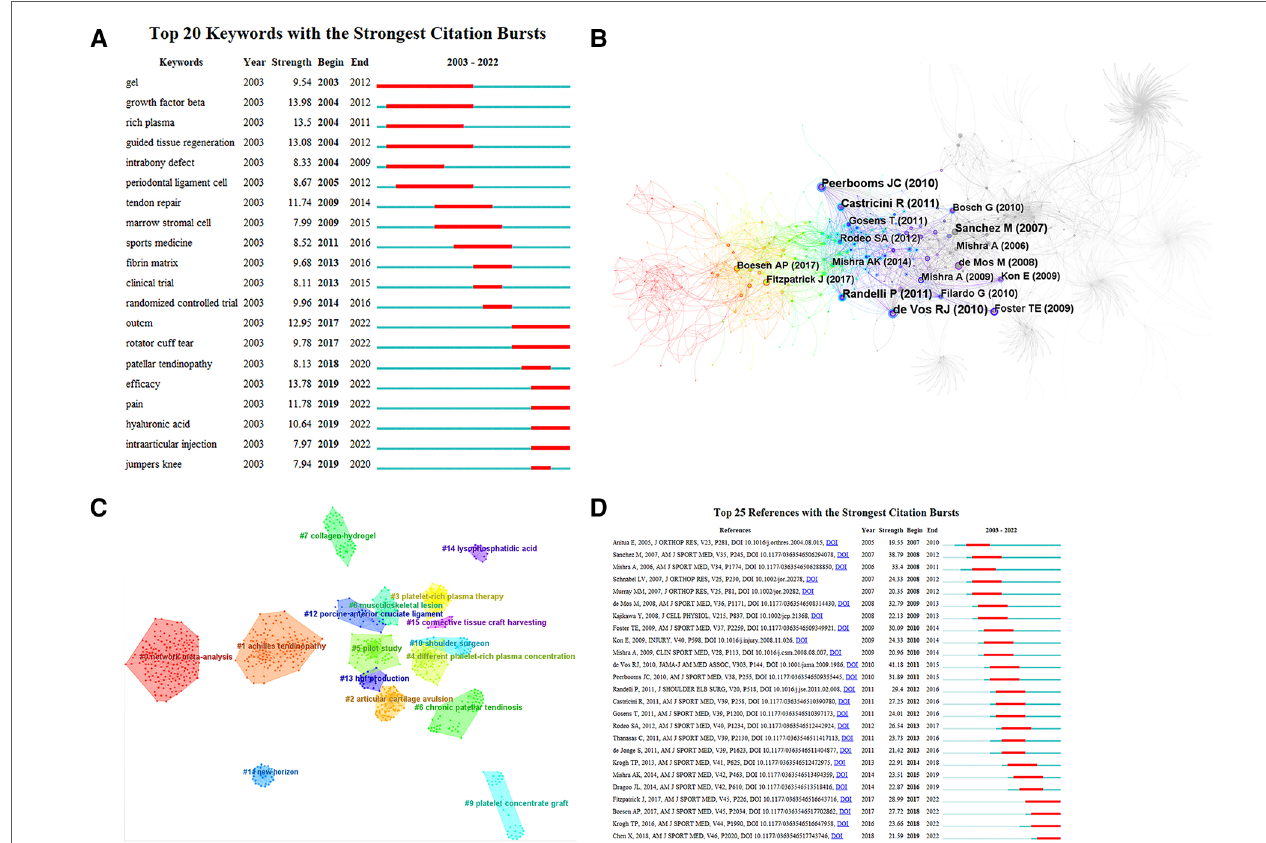
FIGURE 7 ( A ) keyword emergent plots of using platelet-rich plasma to treat ligament and tendon injuries. Note: The fi gure of “–” is 1 year keyword mark, “–” is the emergence of the year of the word. ( B ) Co-citation network of using platelet-rich plasma to treat ligament and tendon injuries. Note: The circles in the fi gure represent keywords, the larger the circle means the higher the frequency of keywords, the dark to light color represents the year from far to near, the connecting line represents the connection between keywords, the thickness of the purple outer circle represents the centrality of keywords, this fi gure is arranged in chronological order from dark to light by clustering color. ( C ) Clustering of co-cited literature on using platelet-rich plasma to treat ligament and tendon injuries. Note: The circles in the fi gure represent keywords, the larger the circle means the higher the frequency of keywords, the dark to light color represents the year from far to near, the connecting line represents the connection between keywords, the thickness of the purple outer circle represents the centrality of keywords, this fi gure is arranged in chronological order from dark to light by clustering color. ( D ) Summary of key literature on using platelet-rich plasma to treat ligament and tendon injuries. Note: The “–” in the fi gure are the years in which the unexpected citations appeared, and the “–” in the fi gure are the nodes in which the number of citations for the unexpected citations suddenly rose, arranged in chronological order from top to